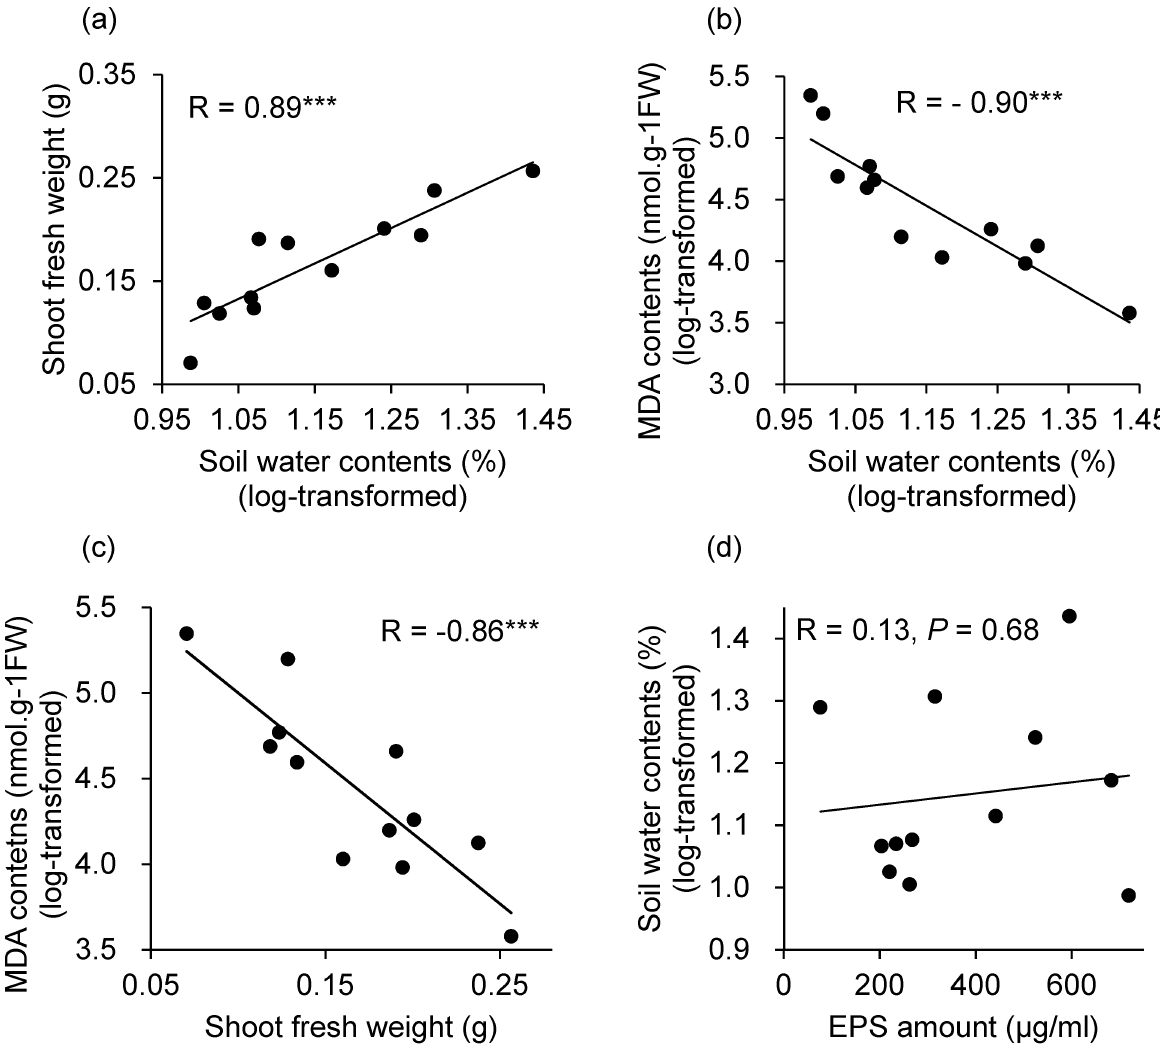
Figure 6. Pearson’s correlation coefficients between the soil water content, shoot fresh weight, malondialdehyde (MDA) concentration, and exopolysaccharides production of